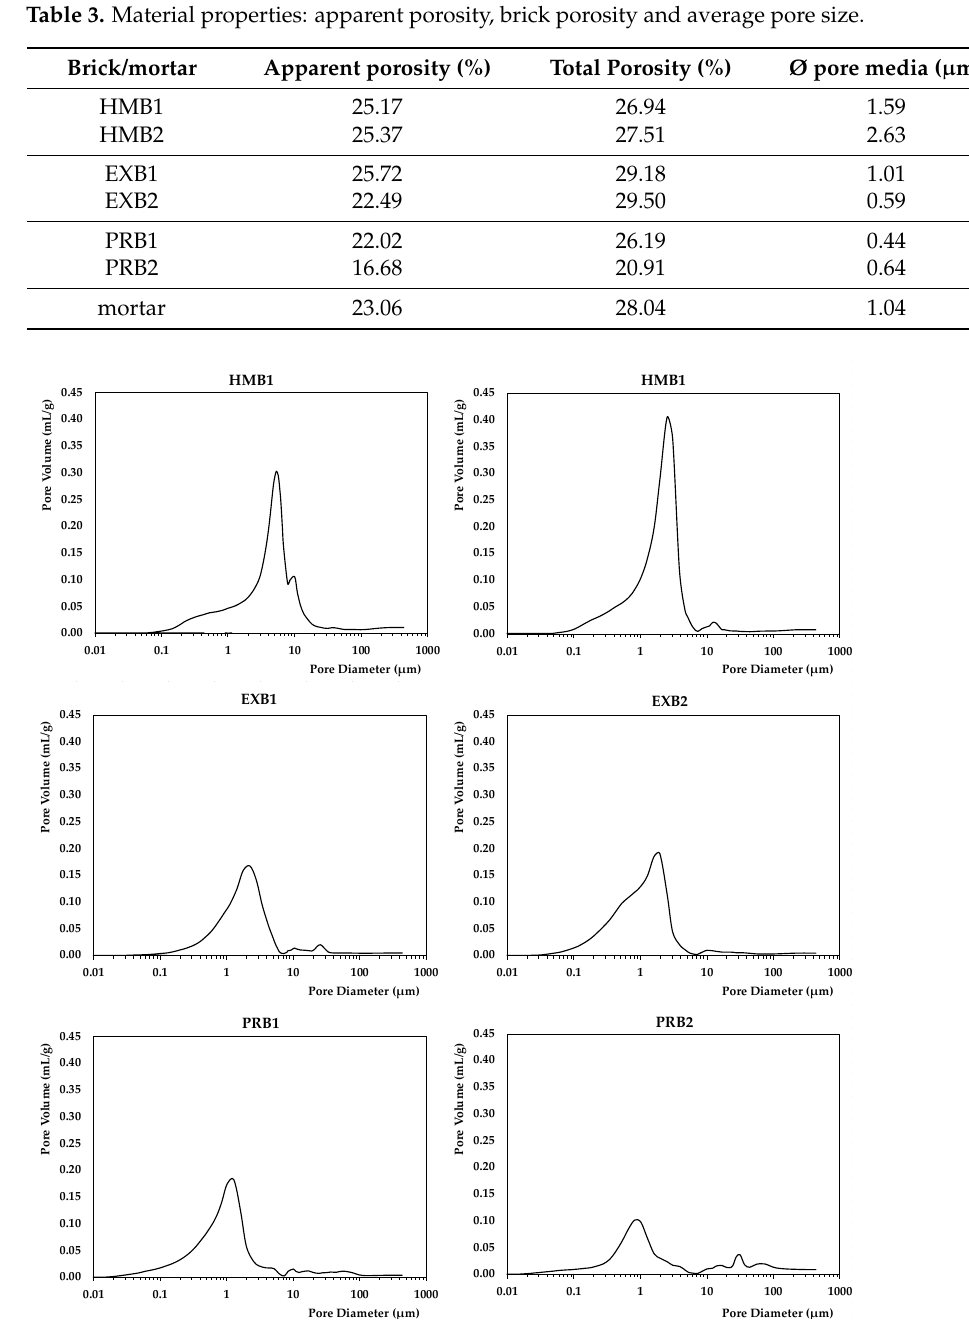
Figure 4. Pore size distribution in samples corresponding to the three types of brick studied.